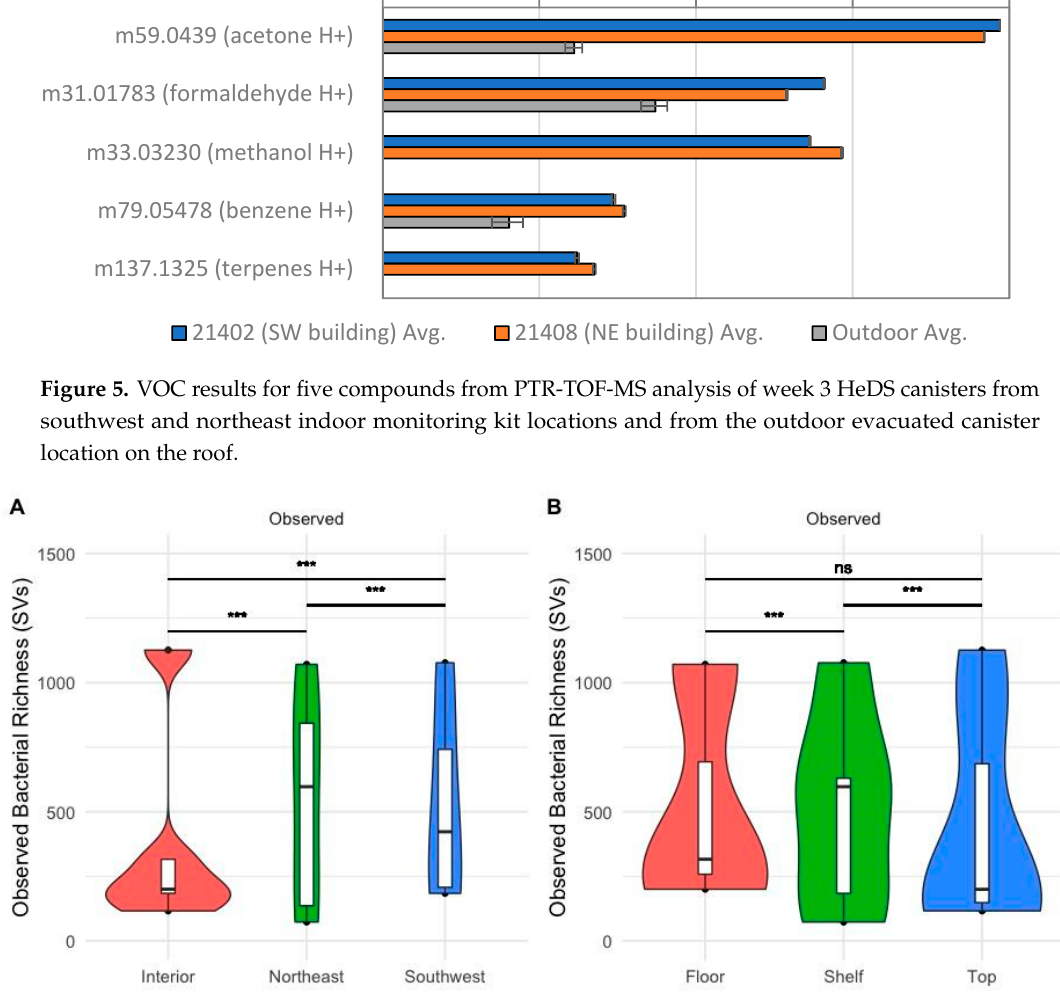
Figure 5. VOC results for five compounds from PTR-TOF-MS analysis of week 3 HeDS canisters from southwest and northeast indoor monitoring kit locations and from the outdoor evacuated canister location on the roof.